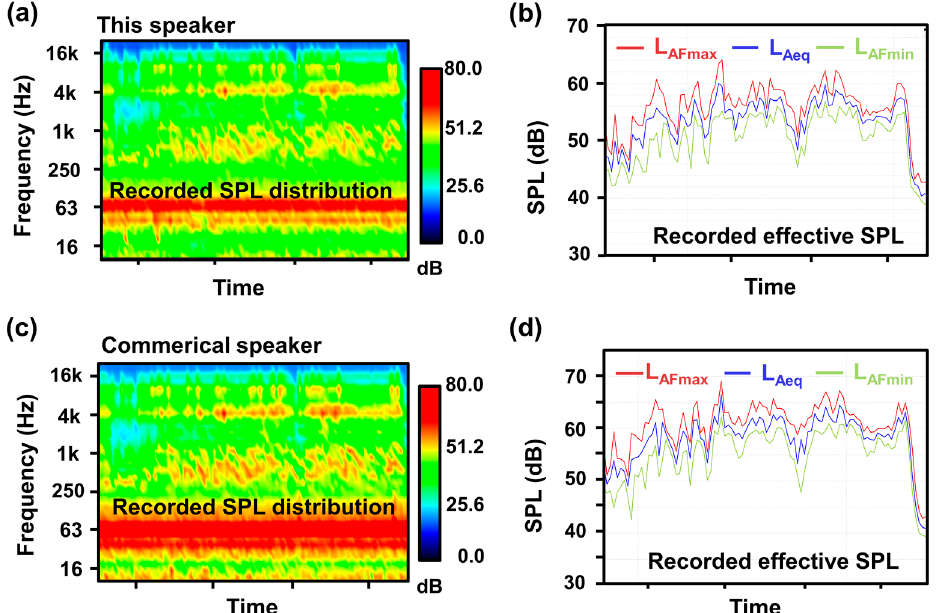
Figure 4. Comparison of a designed piezoelectric MEMS speaker and a commercial one. SPL distribution ( a , b ) effective SPL of proposed speaker at each moment when playing a song. ( c ) SPL distribution and ( d ) effective SPL of a commercial speaker at each moment when playing the same song.